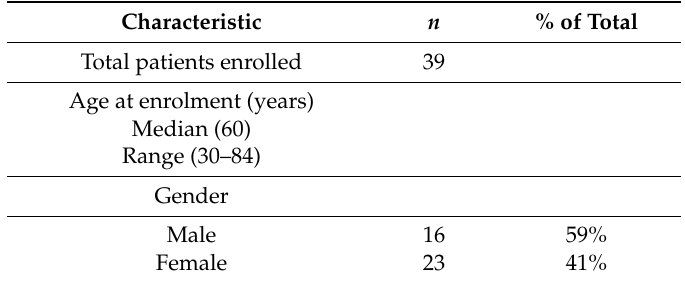
Table 1. Demographic and clinical information of metastatic melanoma